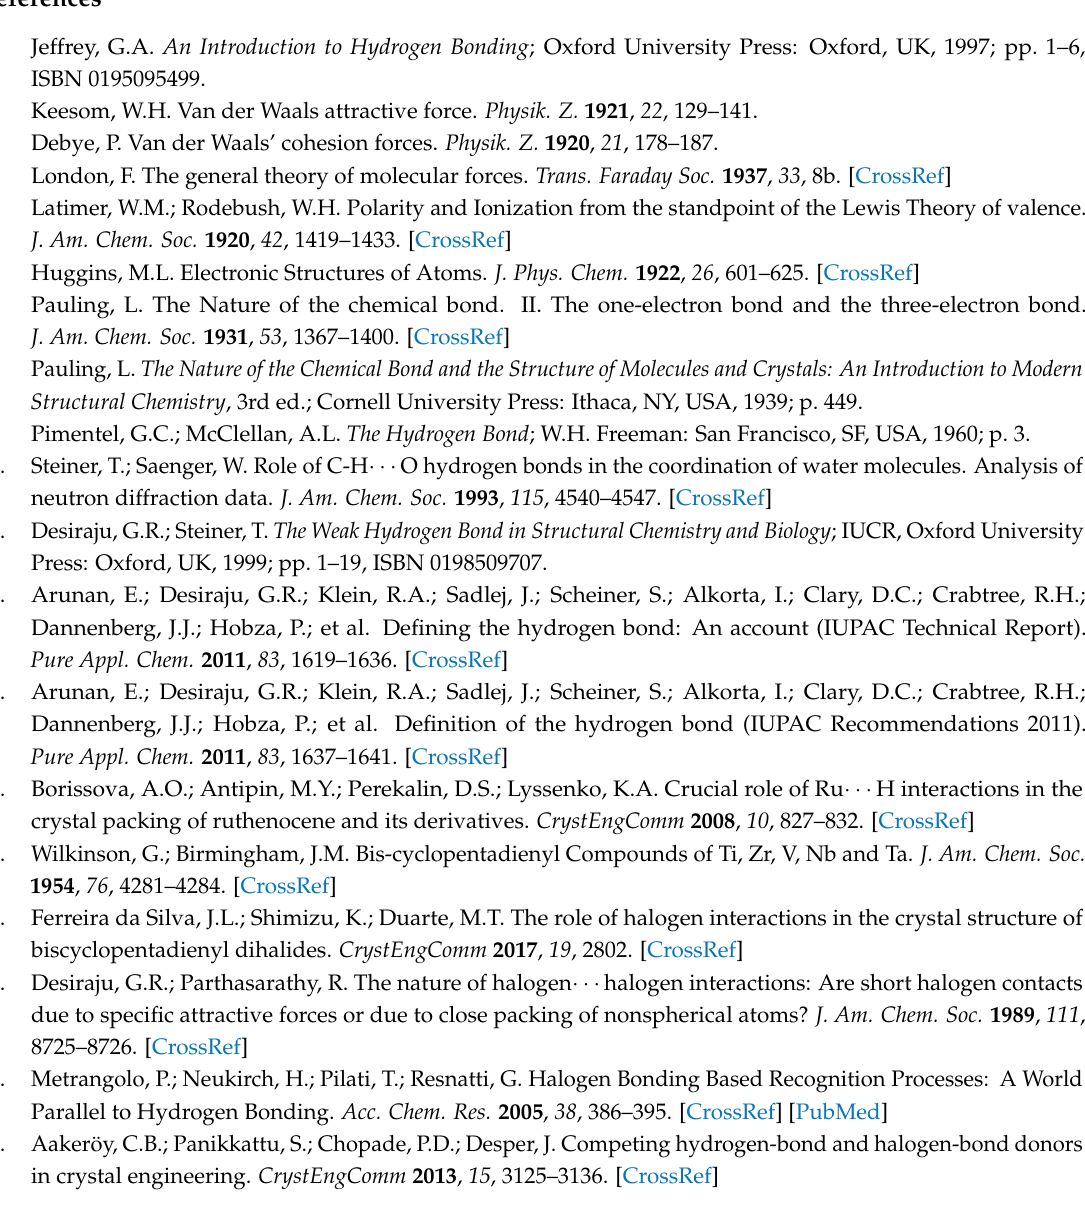
s1, Figure S1. Side and top view of HOMO molecular orbitals surfaces for (CpX) 2 Fe (X = F, Cl, Br), Figure S2. Side and top view of HOMO molecular orbitals surfaces for (CpI) 2 M (M = Fe (isomers A, B, C), Ru), Table S1. Atomic point charges (in atomic charge units percentage, a.c.u.%) for molecules (CpX) 2 M (M = Fe; X = F, Cl, Br, I. M = Ru; X = H), Table S2. Intermolecular contact parameters in (CpF) 2 Fe, Table S3. Intermolecular contact parameters in (CpCl) 2 Fe, Table S4. Intermolecular contact parameters in (CpBr) 2 Fe, Table S5. Intermolecular contact parameters in (CpI) 2 Fe, Table S6. Intermolecular contact parameters in (CpI) 2